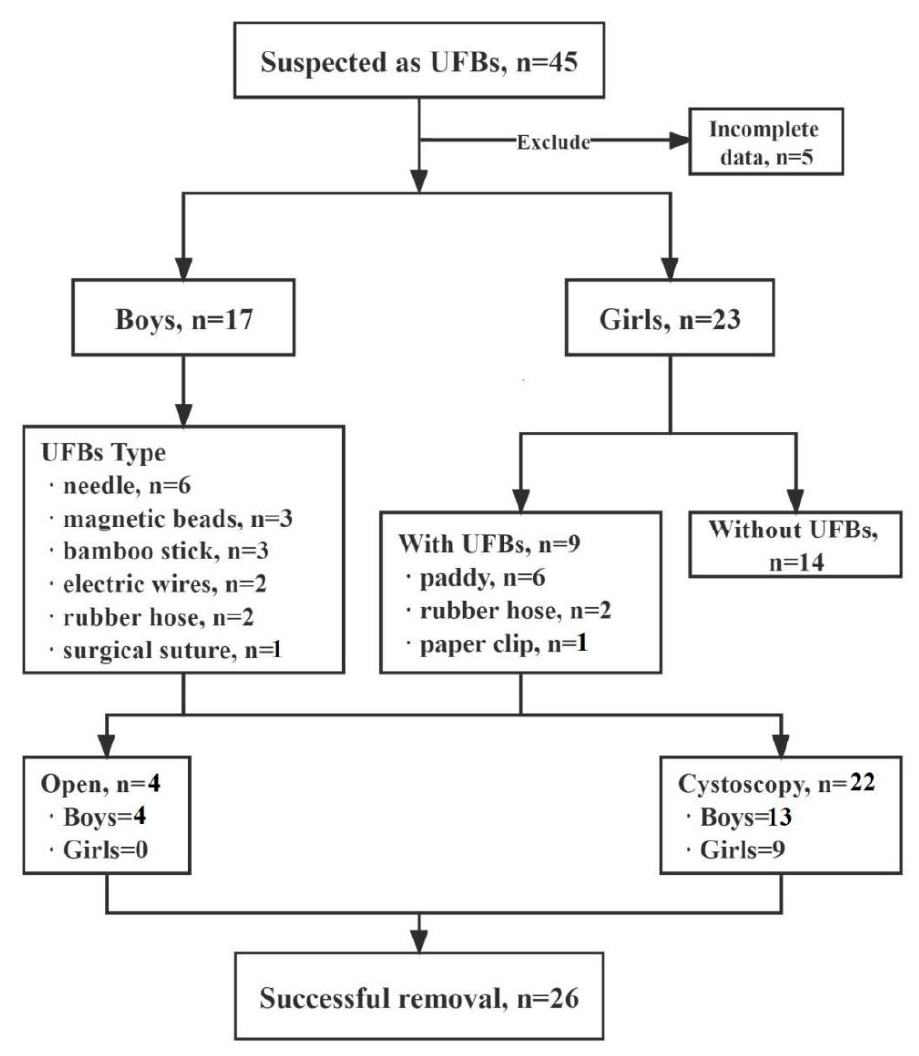
Figure 2. Flow chart of the study. Table 1. Characteristics of the UFBs and their